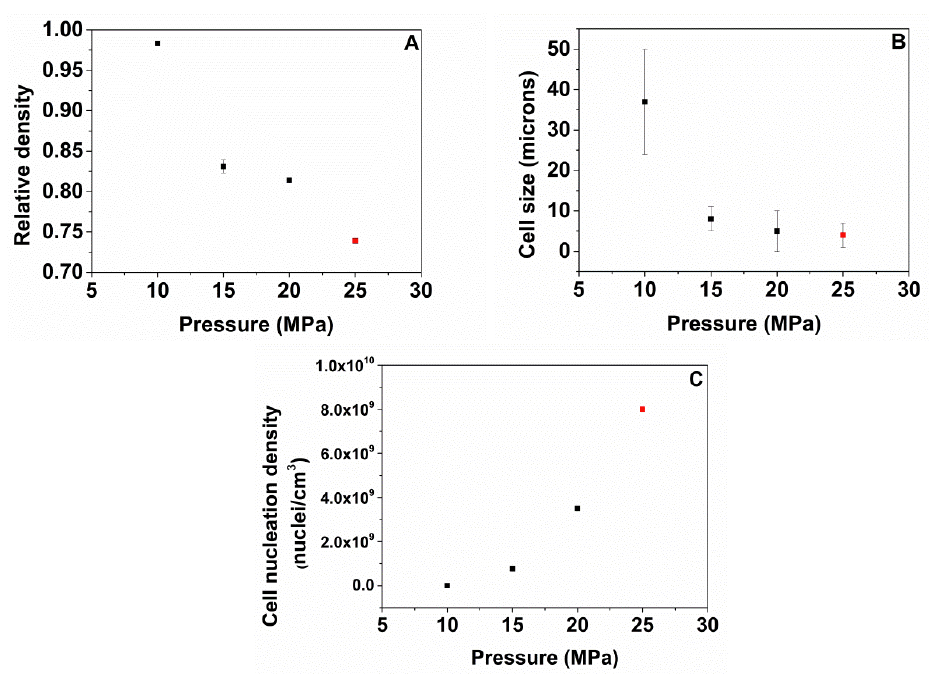
Figure 8. Relative density ( A ), cell size ( B ), and cell nucleation density ( C ) of TPU 50%HS foamed by one step between 10 and 25 MPa, 170 ° C, and 1 h.